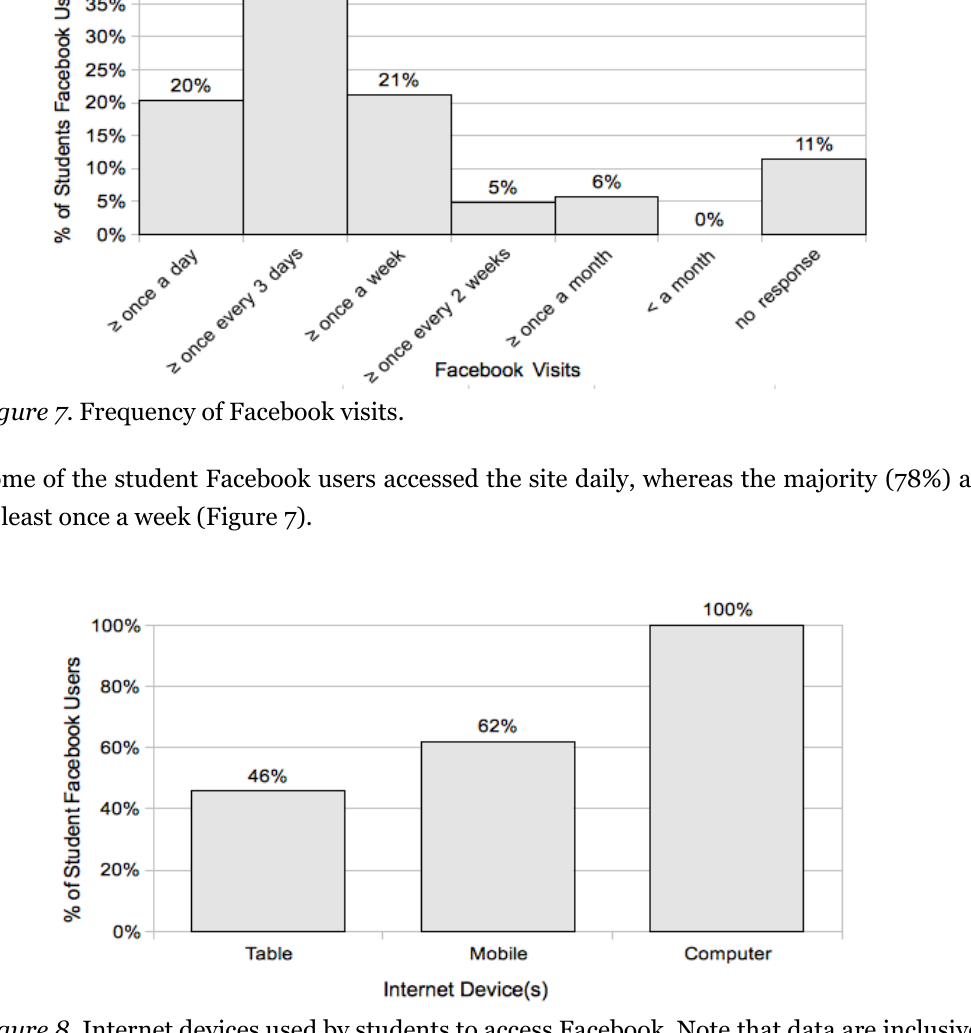
Figure 8. Internet devices used by students to access Facebook. Note that data are